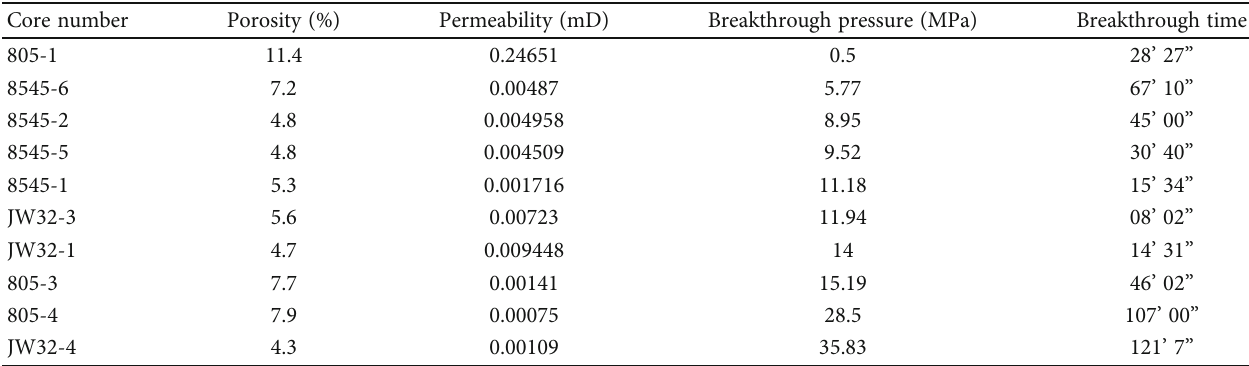
Figure 14: Core preparation processes before the injection breakthrough pressure evaluation experiment. Table 5: Experimental results of gas injection sealability evaluation at the top of the cubic